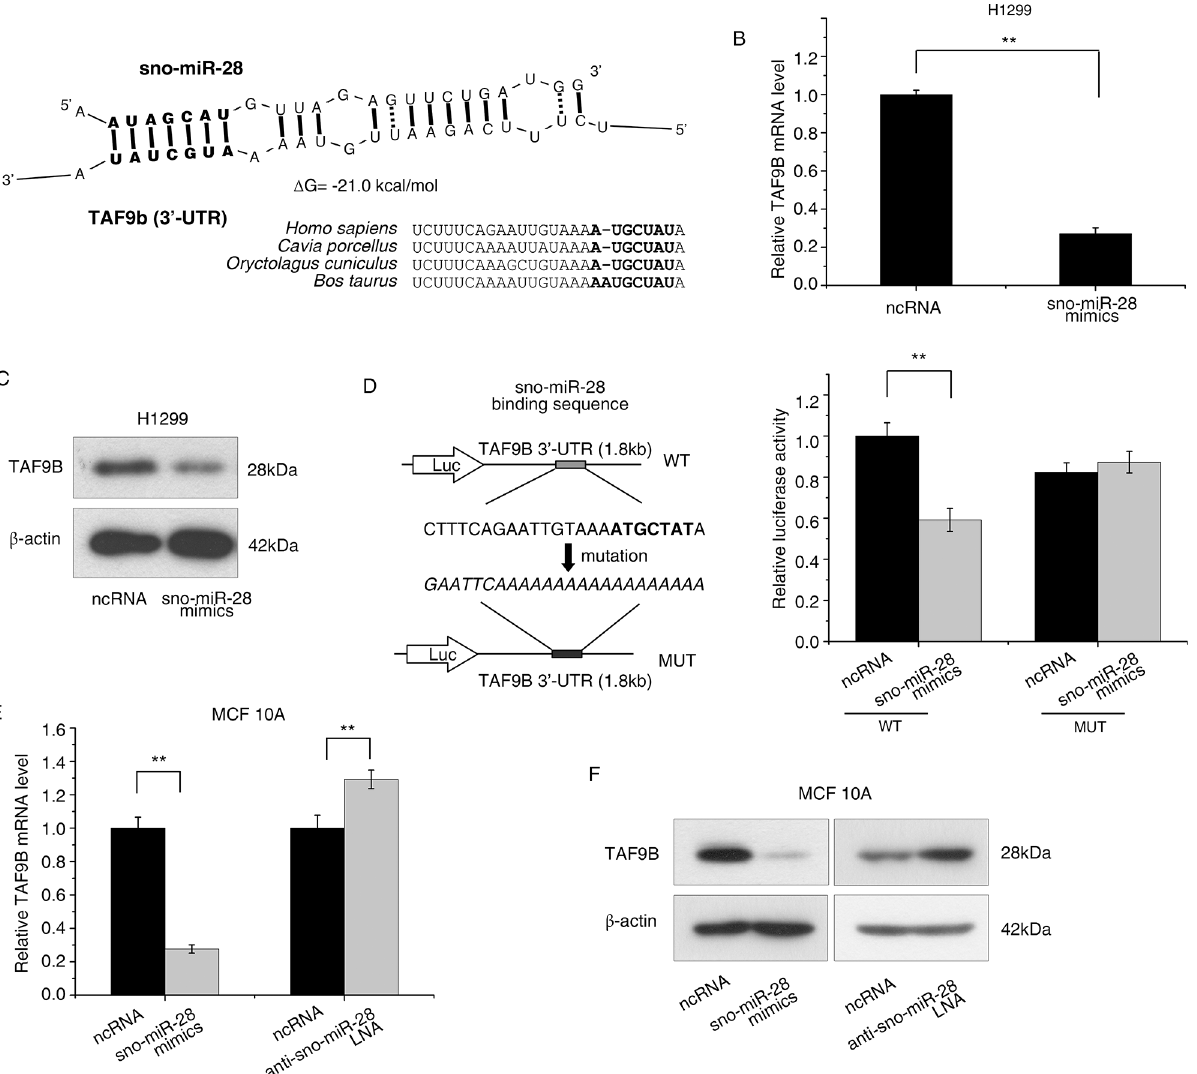
Fig 3. sno-miR-28 functions as a miRNA. (A) Proposed sno-miR-28 binding site within the TAF9B 3 ’ UTR. The seed-recognition site is marked in bold; hypothesized duplexes formed by the interaction of TAF9B and sno-miR-28 are illustrated, and the predicted free energy of the hybrid is indicated. Conservation of the seed region across 4 species is also indicated. (B, C) sno-miR-28 (or negative control RNA, ncRNA) was overexpressed in H1299 cells. TAF9B mRNA and protein levels were determined by RT-PCR and Western blot, respectively. (D) Using a dual-luciferase reporter system, H1299 cells were co-transfected with sno-miR-28 mimics (or negative control RNA), and psiCHECK2 luciferase reporter plasmids with either wild type (WT) or mutated TAF9B 3 ’ -UTR (MUT) cloned at downstream of the Renilla luciferase gene (Luc). Relative luciferase activities are shown. (E, F) sno-miR-28 was either overexpressed (mimics) or inhibited (LNA) in MCF10A cells. TAF9B mRNA levels were determined by RT-PCR (E), and protein expression was determined by Western blot (F). ** p < 0.01 versus controls for all experiments, and β -actin was included as a loading control for all Western